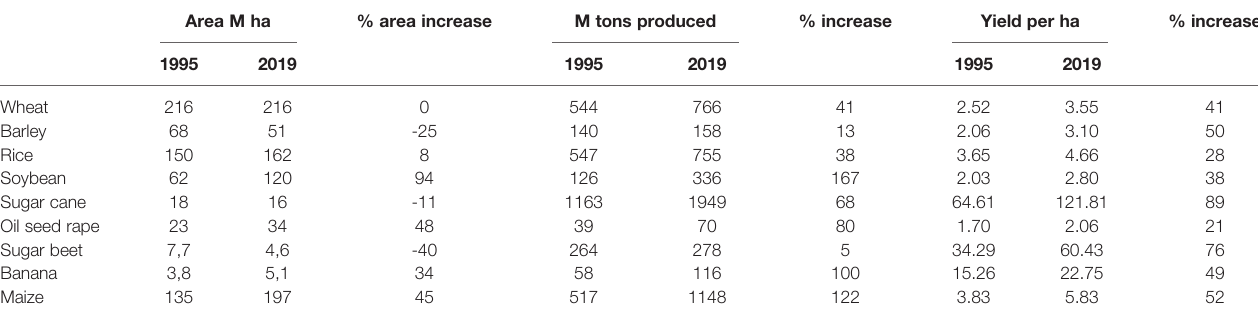
TABLE 3 | Data illustrating the intensi fi cation of agricultural production during the last 25 years (FAOstat). Area M